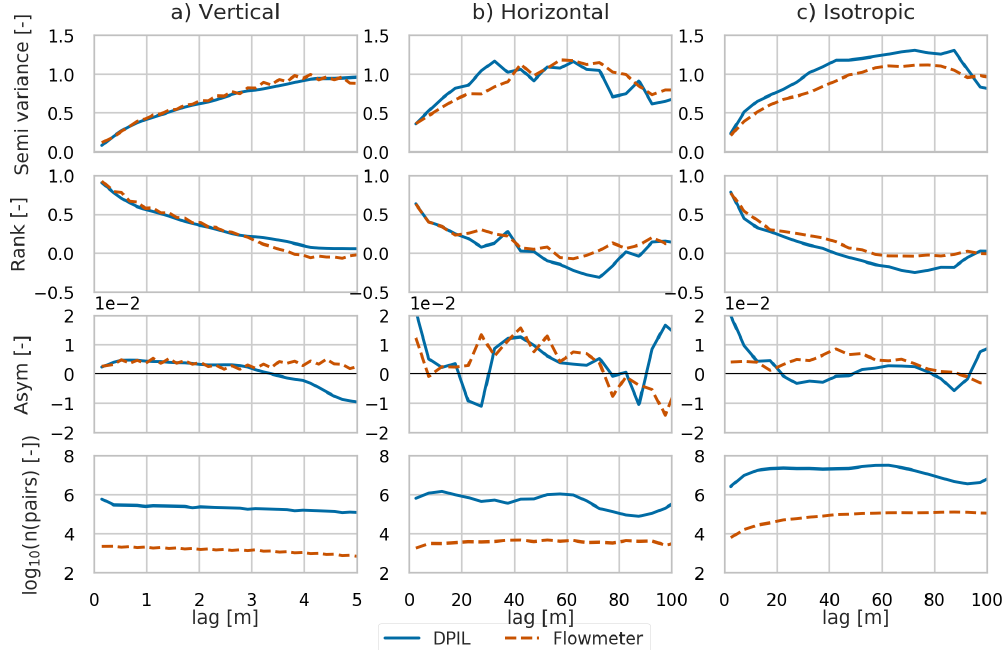
Figure 4. Bivariate measures in the vertical direction (panel ( a )), the horizontal direction (panel ( b )) direction, and the isotropic case (panel ( c )). From top to bottom are: normalized semivariogram, copula-based rank correlation ( Rank ), asymmetry ( Asym ), number of data pairs